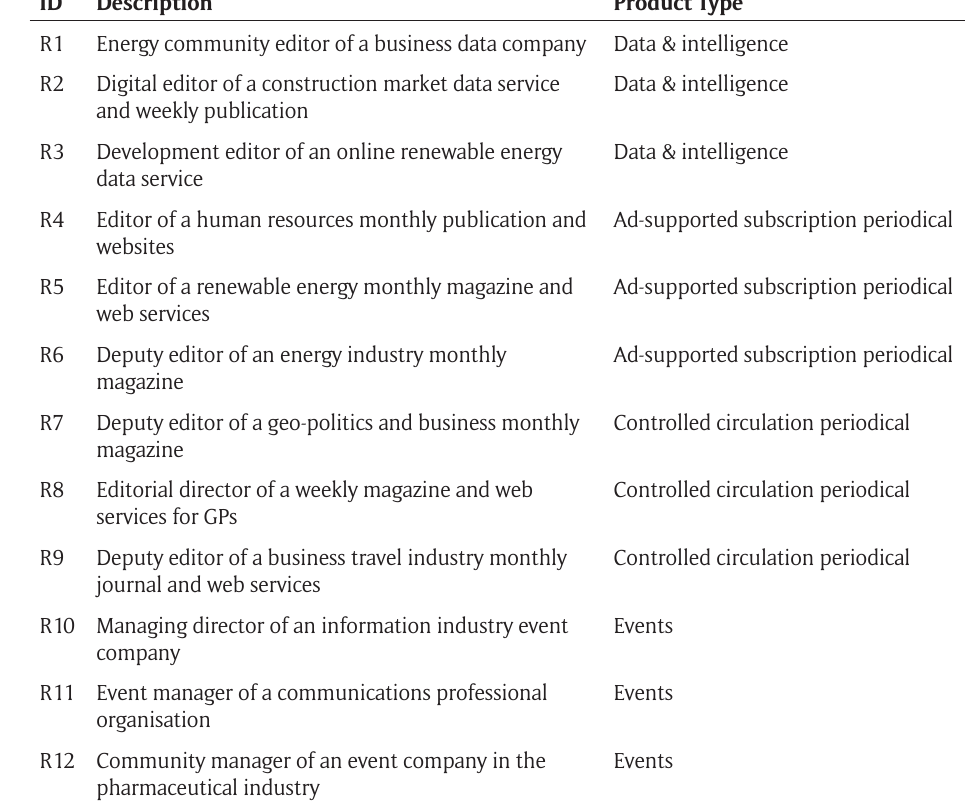
Table 2: Interview